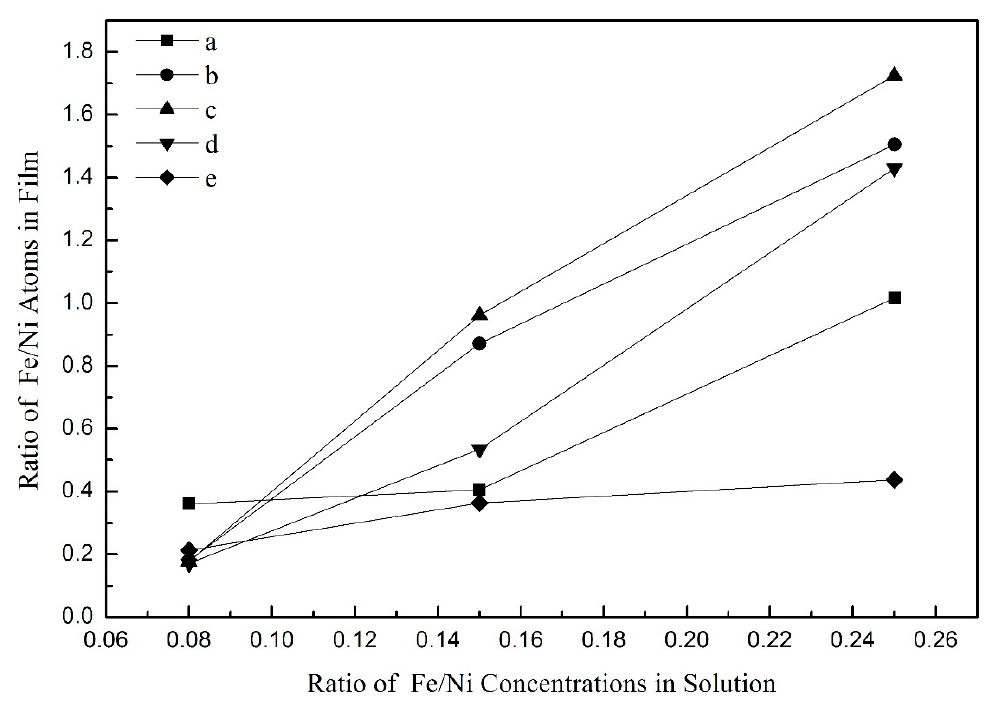
Figure 6. The relationship between the atomic ratio of Fe/Ni in the electrodeposited films and the concentration ratio of Fe(II)/Ni(II) in the deposited solution: (a) 15 mA · cm − 2 , (b) 20 mA · cm − 2 , concentration ratio of Fe(II)/Ni(II) in the deposited solution: (a) 15 mA·cm − 2 , (b) 20 mA·cm − 2 , (c) 25 (c) 25 mA · cm − 2 , (d) 35 mA · cm − 2 , (e) 50 mA · cm − 2 mA·cm − 2 , (d) 35 mA·cm − 2 , (e) 50 mA·cm − 2 .